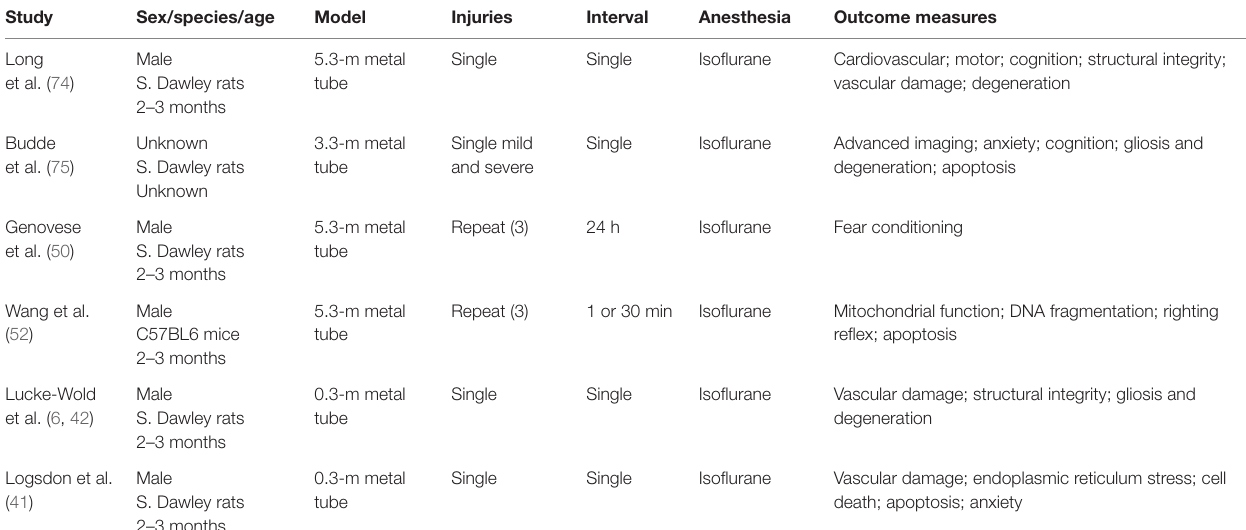
TABLe 2 | Shock tube TBi